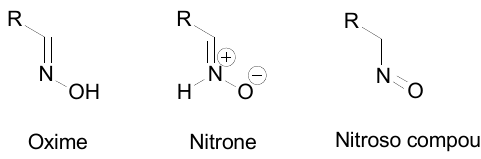
Figure 5. Tautomers of oximes.